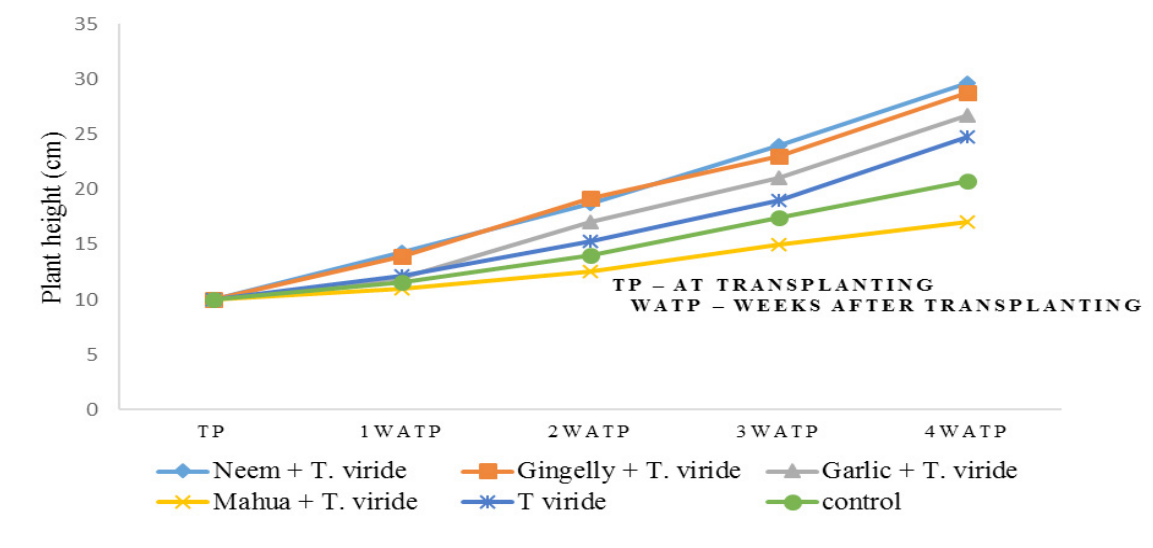
Figure 3: Growth rate of chilli in different T. viride